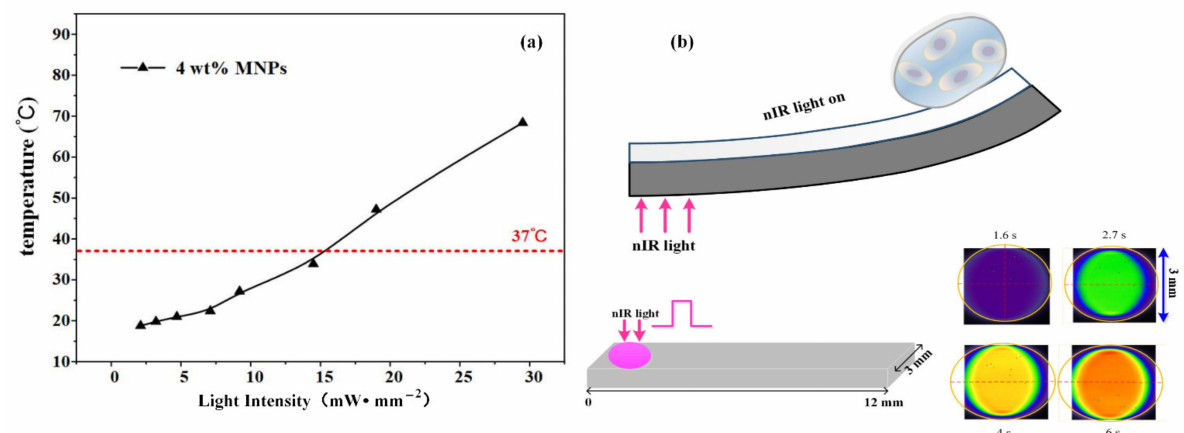
Figure 6. Temperature change and distribution of soft bilayers as illuminated by nIR light. ( a ) The temperature change in the soft bilayer surface under various nIR light intensities. ( b ) Temperature distribution of the soft bilayer